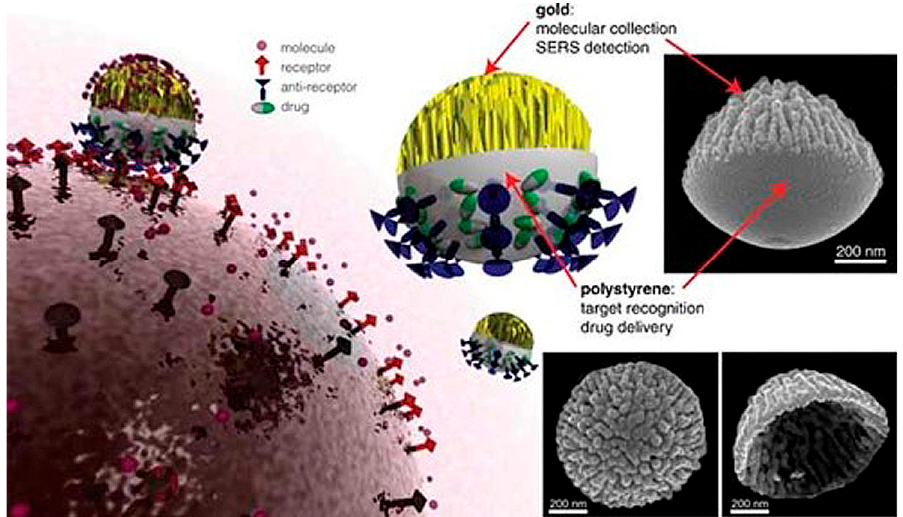
Figure 4. Nanocorals in Janus structure as multifunctional targeting, sensing, and drug delivery nanoprobe; Inset: Scanning electron microscope (SEM) images of Janus structured nano-coral probes. Reproduced with permission from Wu et al. (2010), © Wiley, 2010 [42].